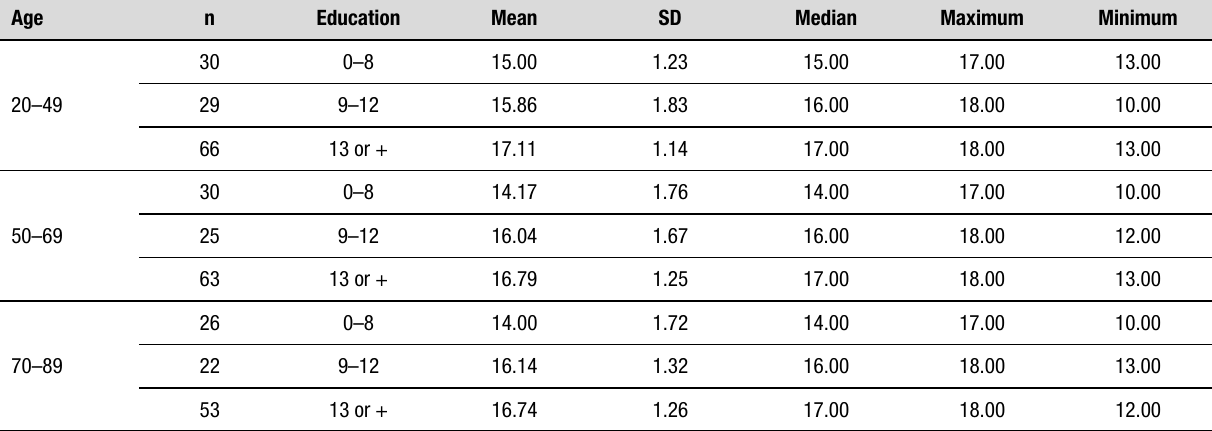
Table 5. Normative data for the Frontal Assessment Battery score total.